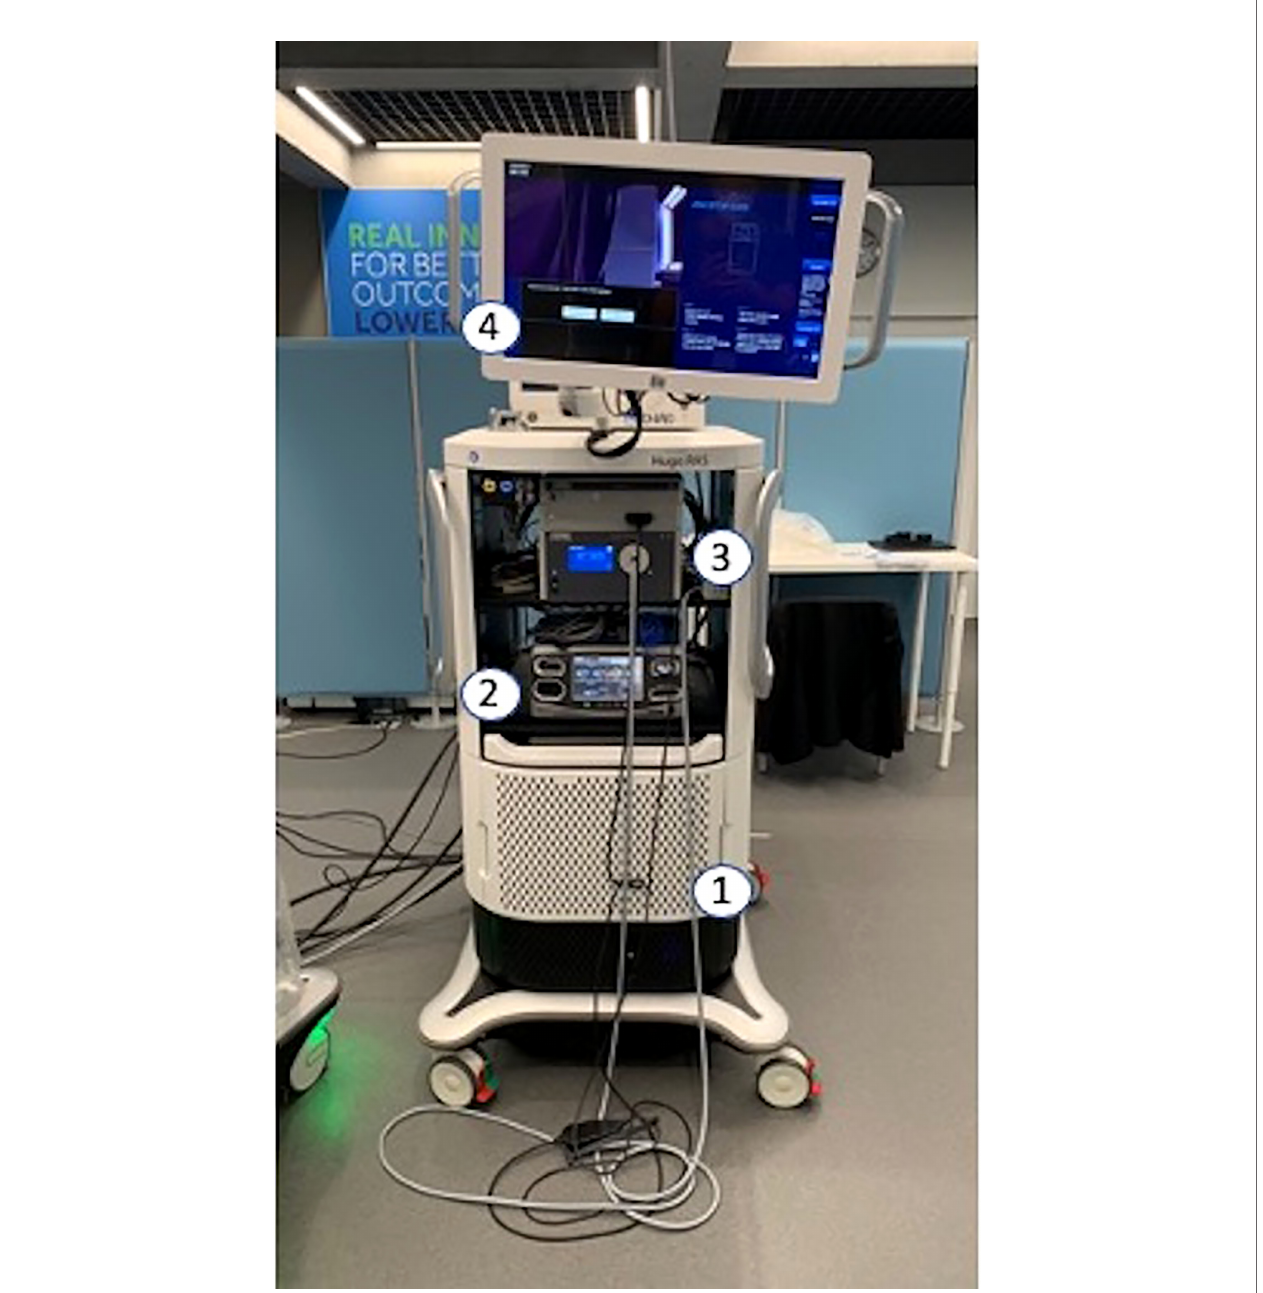
FIGURE 2 | 1 — Computers and power management; 2 — Electrosurgical generator; 3 — Vision System; 4 — 2D Touchscreen